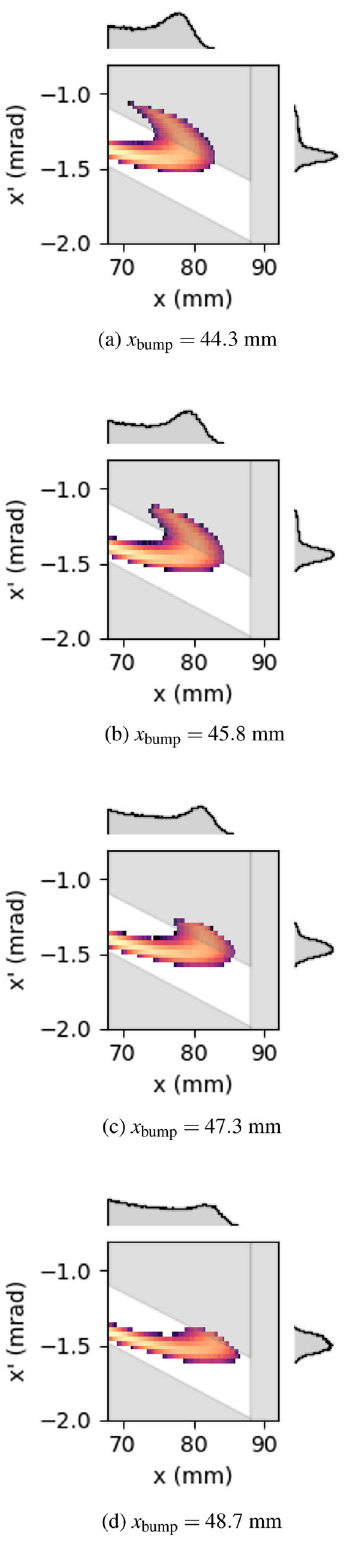
FIG. 11. Extracted beam in phase space on the high-field side upstream of the ZS simulated as a function of extraction bump amplitude strength with 2.1 times the nominal LSE strength,